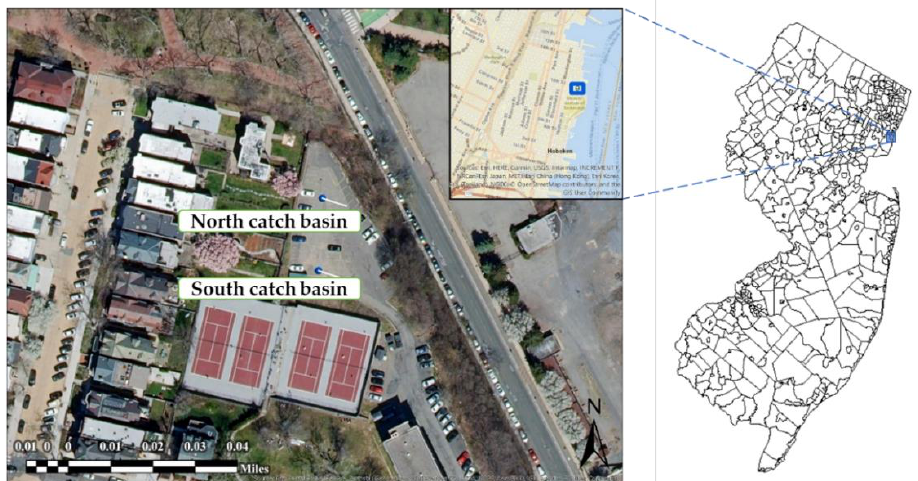
Figure 1. Aerial photo of the two catch basins at the Stevens CPH parking lots, Hoboken, NJ, USA.